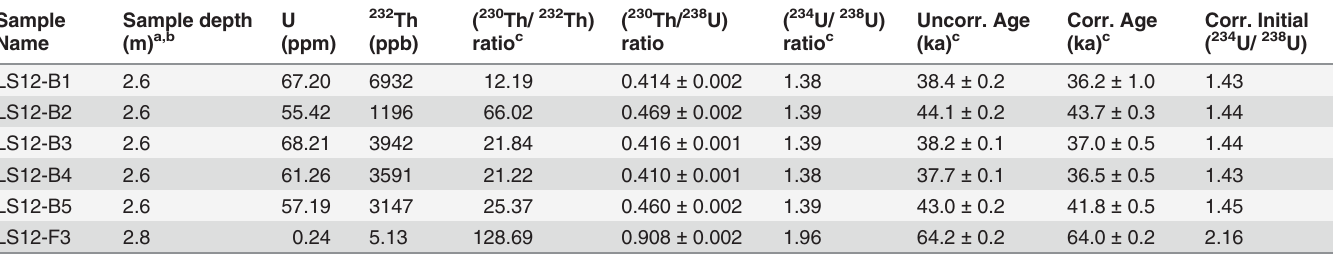
Table 2. Uranium-series dating of Tam Pa Ling stalactite and TPL2 bone: ages and supporting data. Sample